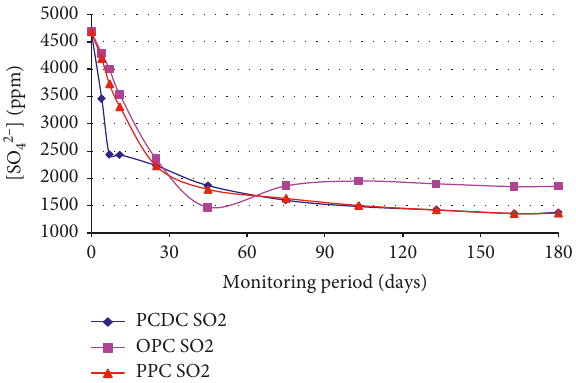
Figure 10: SO 42 analyses in sulphate-simulated solution 2. −